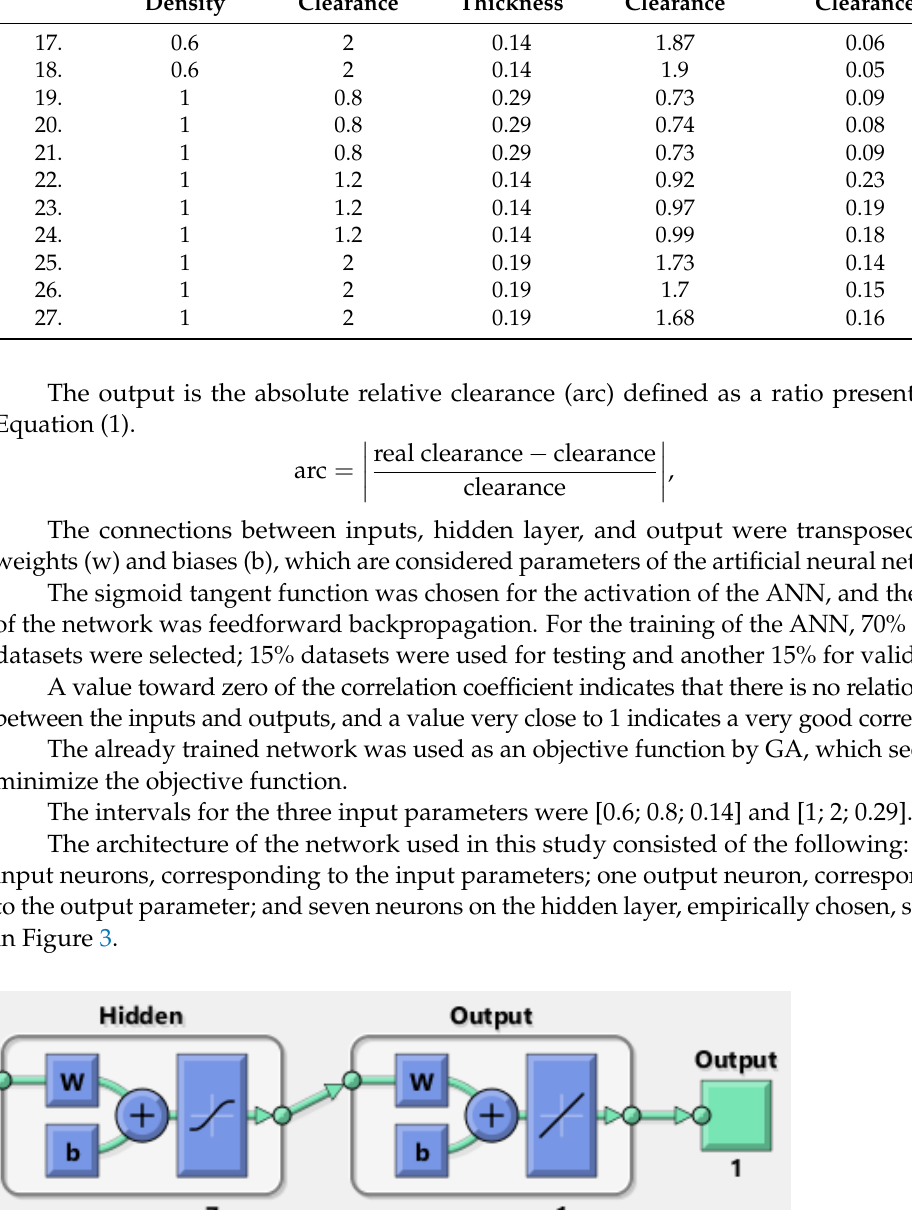
Figure 4. The training process results . 3. Mathematical Modeling The mathematical modeling of the clearance as a function of the imposed clearance (further on denoted by 𝑥 ), layer thickness (further on denoted by 𝑦 ), and infill density (further on denoted by 𝑧 ) requires the selection of a candidate function that depends on three variables. Usually, this function is selected as a polynomial one, a higher degree of the polyno- mial implying a higher precision. The coefficients of the selected polynomial are obtained by using the least squares method. The significant problems with such a polynomial func- tion are at least the following: (i) the values of this function may be negative in some in- tervals; (ii) the function does not linearly tend to infinite when the imposed clearance tends to infinite; (iii) the clearance starts to grow from zero when the imposed clearance increases over a limit; and (iv) the slope of clearance has to be zero at that critical value when the clearance starts to have non-zero values. Practically, when the imposed clear- ance is sufficiently great, the resulted clearance is approximately equal to the first one. Moreover, if the imposed clearance is small enough, the obtained clearance is equal to zero. Considering these remarks, it results that the candidate function must not be a pol- ynomial in the variable 𝑥 . As candidate function, we choose the following simple one: (